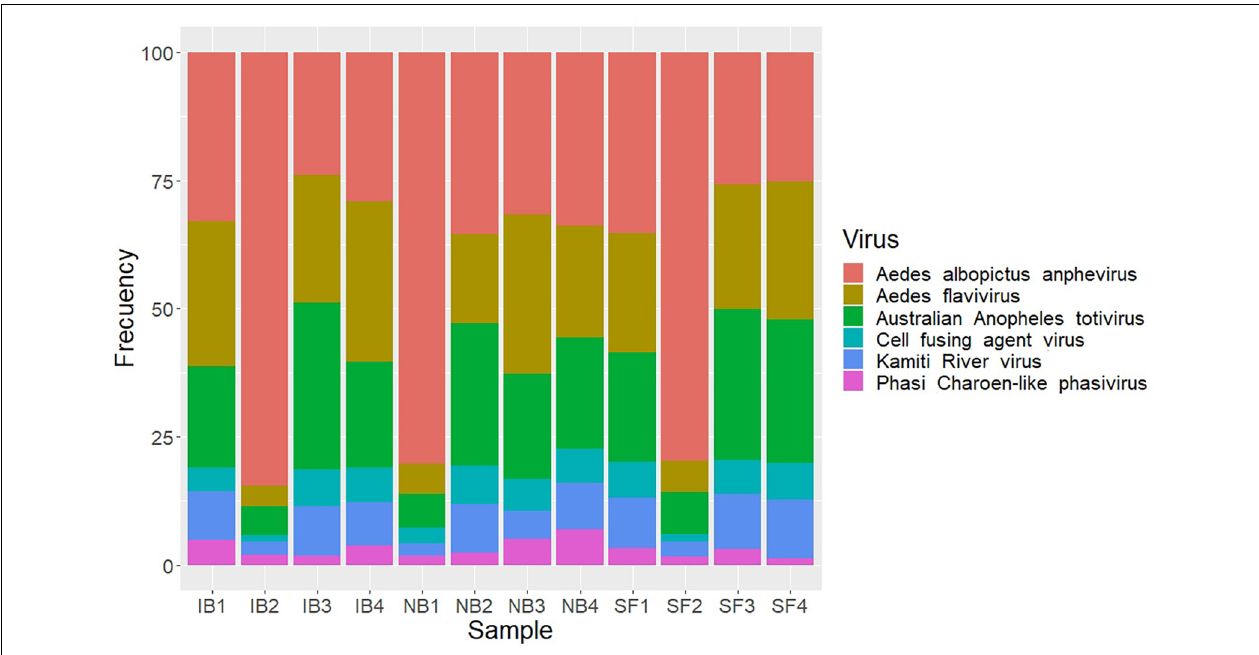
FIGURE 9 | Stacked bar plots showing relative abundance of viral species identified after feed treatments.